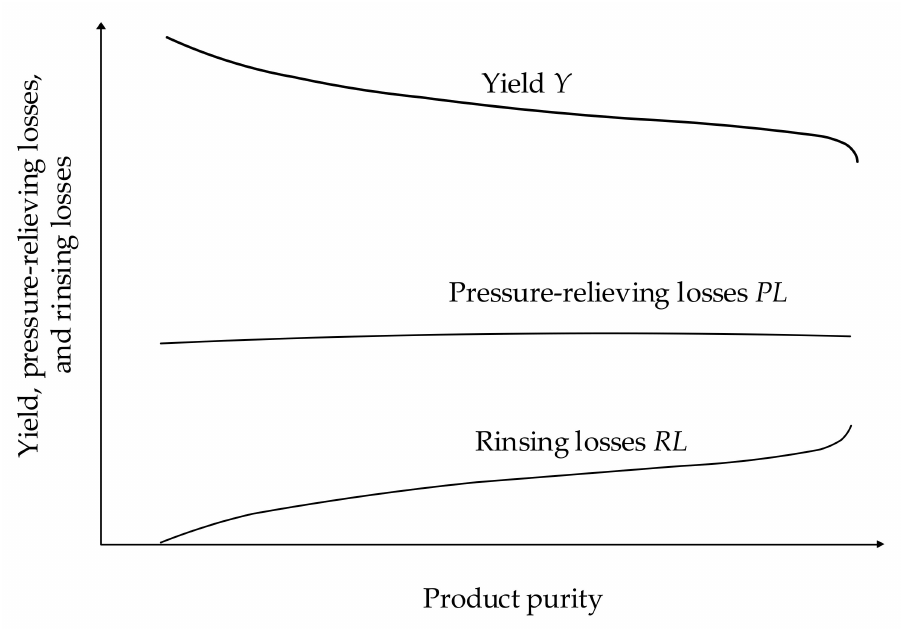
Figure 8. Qualitative development of Y , PL , and RL over the product purity, emulated from [21] (p. 127).